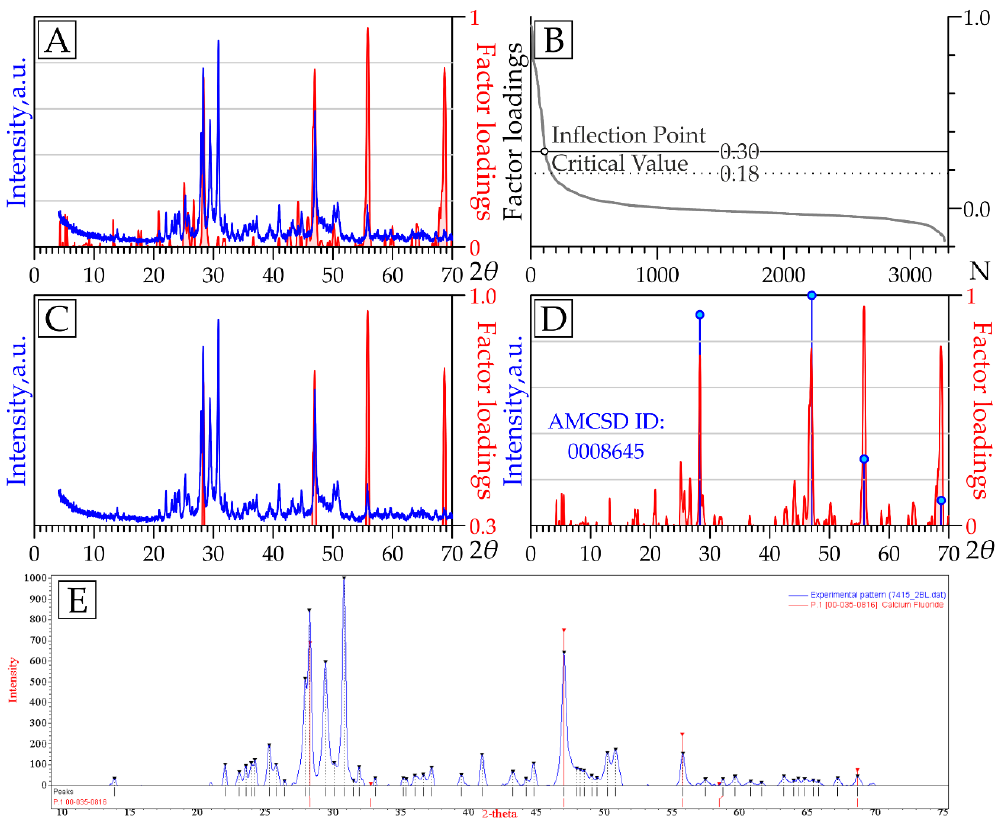
Figure 10. ( А ) Comparison of the full FL graph of fluorite factor #14 (red line) with the diffractogram of a sample with the maximum FS of this factor (blue line); ( B ) Ranked range of FS values of the fluorite factor; ( C ) Comparison of the most significant peaks of the FL graph of fluorite factor (red line) with the diffractogram of a sample with the maximum FS of this factor (blue line); ( D ) Comparison of the full FL graph of fluorite factor with fluorite peaks from the AMCSD online XRPD database; ( E ) QualX v. 2.24 dialog box with a diffractogram of the sample with the maximum FS of fluorite factor (red peaks correspond to PDF2 fluorite card).